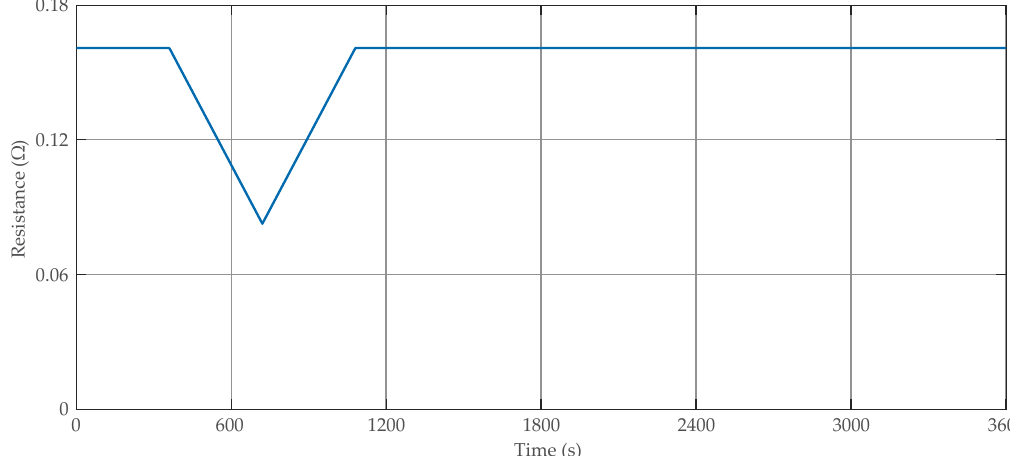
identification. L